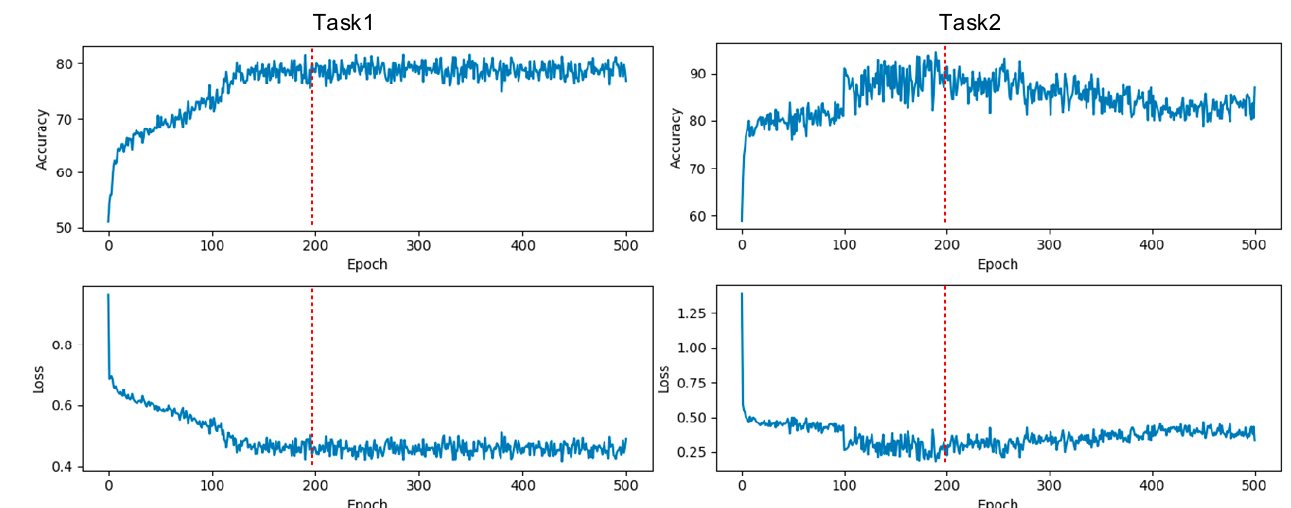
Figure A2. The architecture of the proposed 3D CNN-based DNN model.